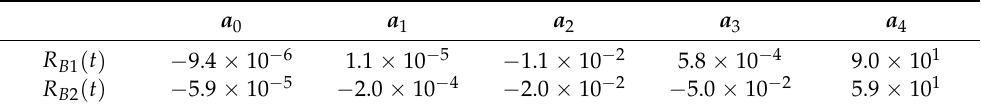
Table 2. Factors in the polynomial function.